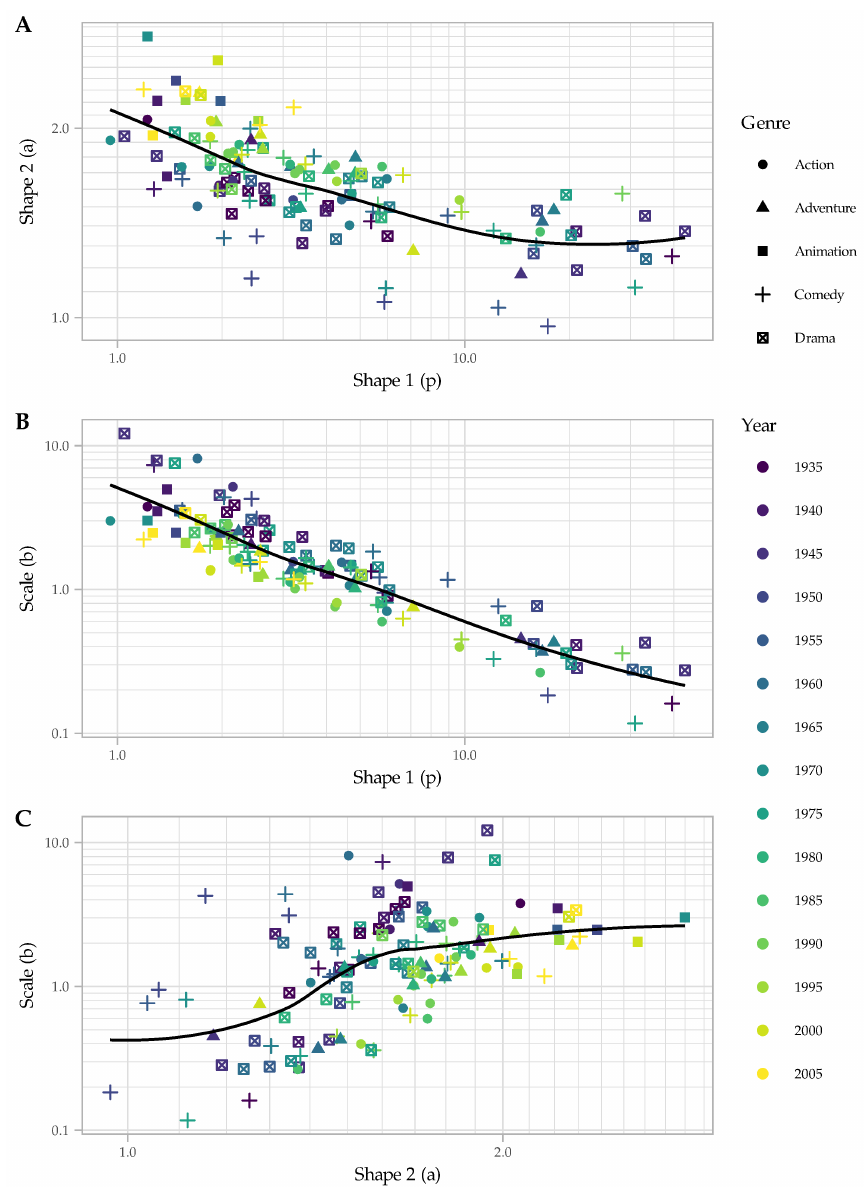
Figure 4 – Parameter relationships of the three-parameter Dagum distribution fitted to shot length data of 134 Hollywood films released from 1935 to 2005 (Source: Cutting et al. (2010); http: //www.cinemetrics.lv/database.php) , with loess